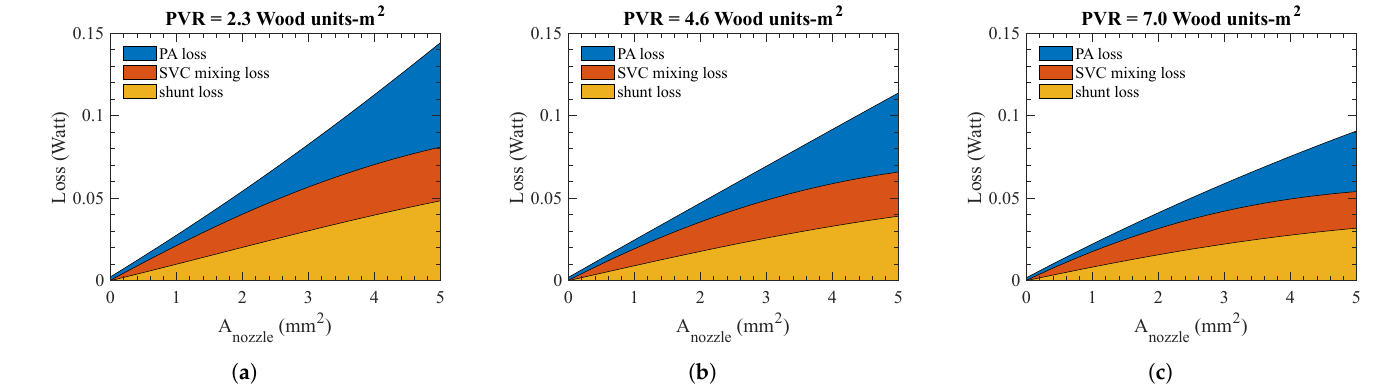
Figure 11. The locations where energy losses occur in the ABG circulation at ( a ) normal PVR, ( b ) elevated PVR, and ( c ) high PVR. These results are obtained from the algebraic